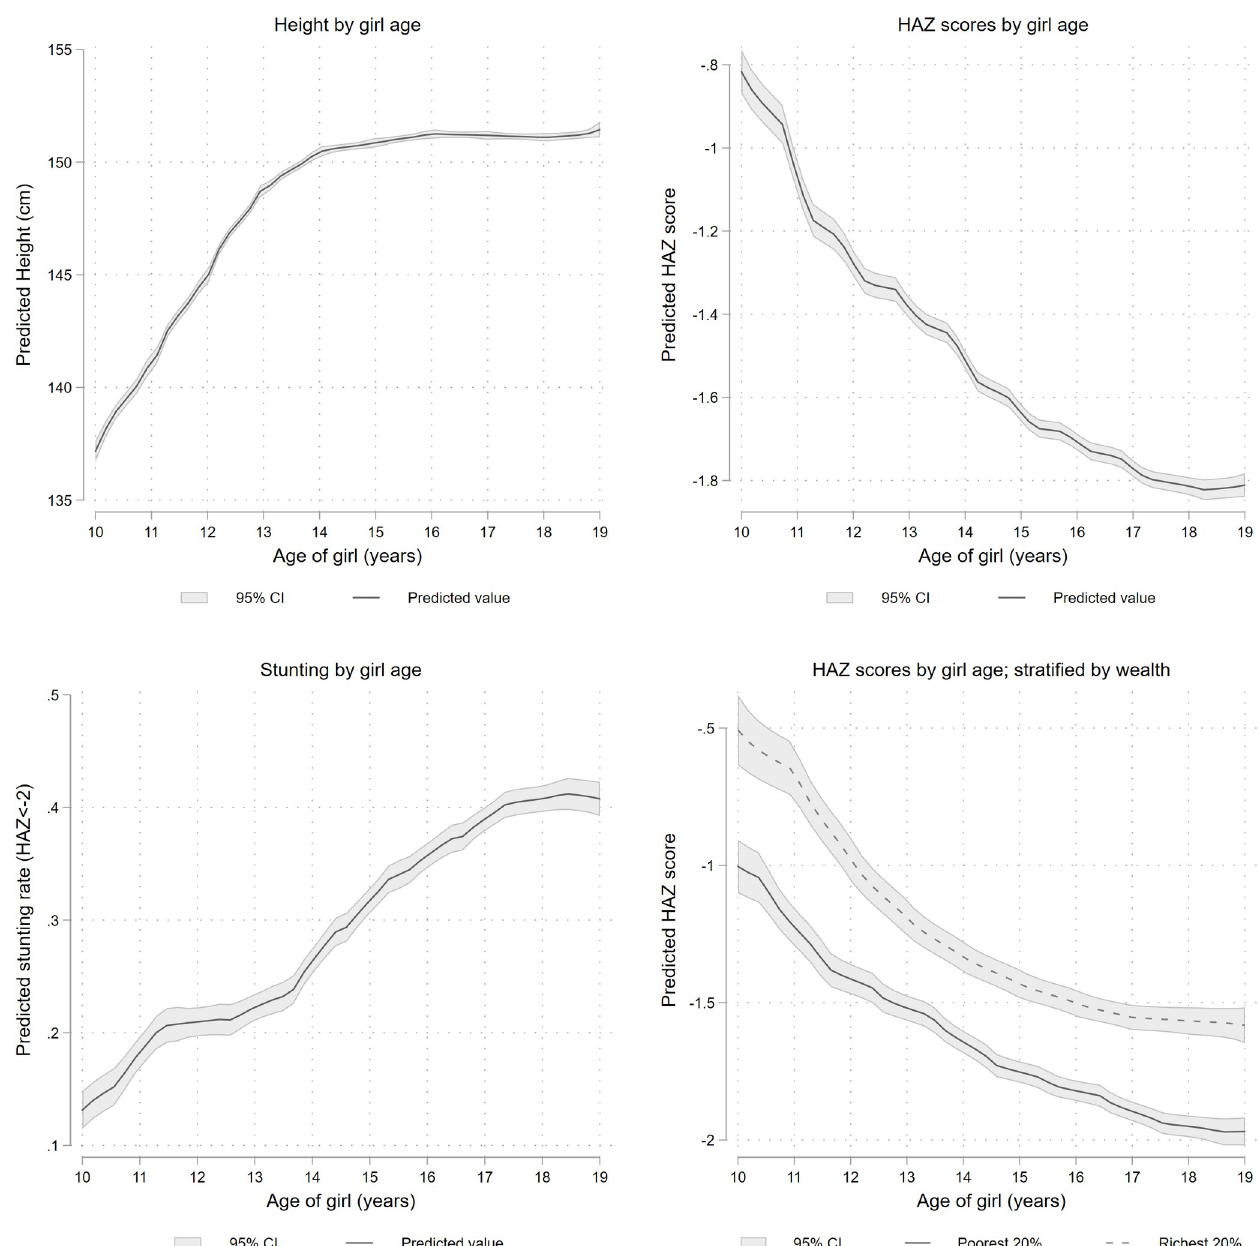
Fig 1. Age dynamics in linear growth of adolescent girls in Bangladesh. (A) Height by girl age (B) HAZ scores by girl age. Z-scores express height in terms of standard deviations below or above the reference median value. (C) Stunting by girl age. (D) HAZ scores by girl age, stratified by wealth.